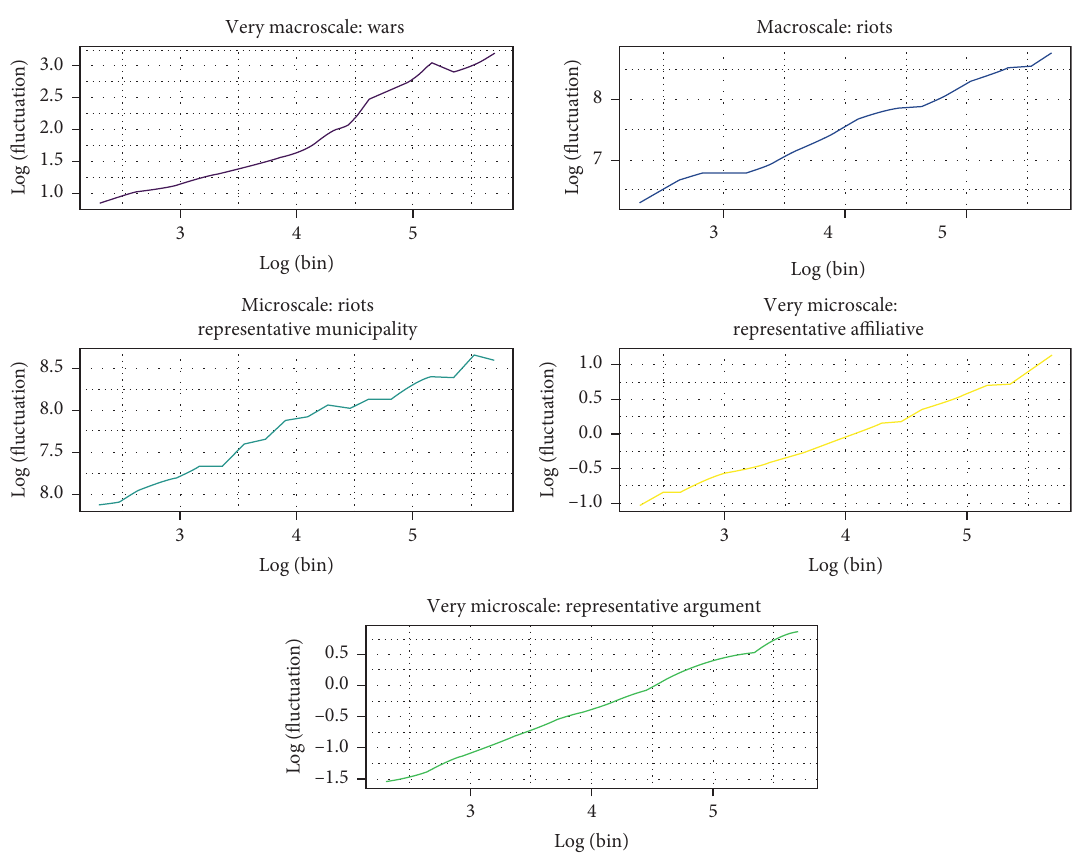
Figure 2: Log(fluctuation) by log(bin size) plots for Wars and Riots; representative log(fluctuation by log(bin size) plots for Crime (Applewood, WI), and Argumentative/Affiliative Conversations. Crime and Conversation samples displayed are closest to the group mean H.